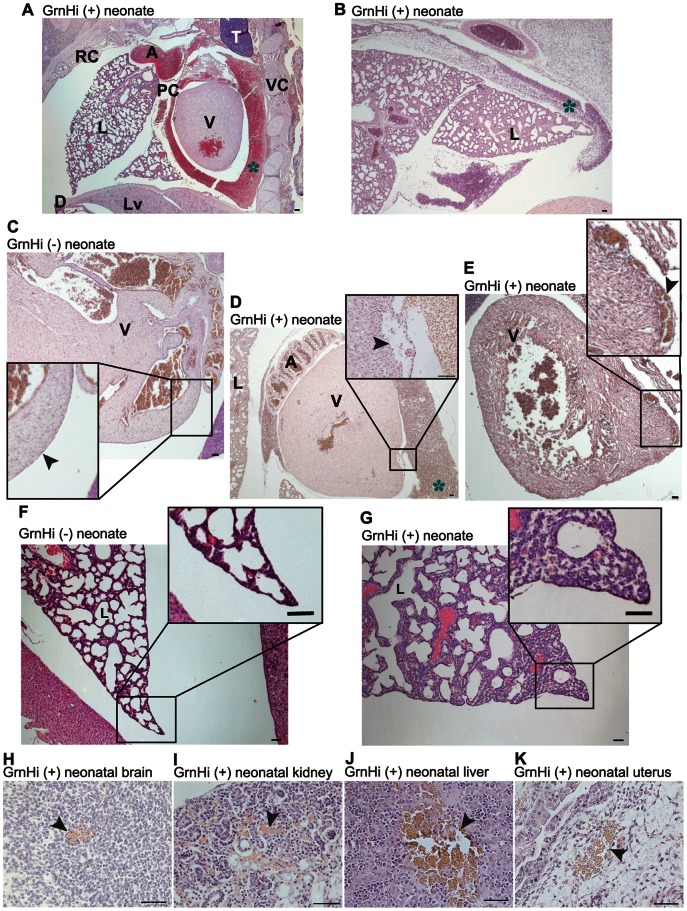
Vascular abnormalities and altered lung structure in Tie2-Grn positive neonatal mice.Extravasated blood (*) in the pericardial cavity (A) and in the pleural cavity adjacent to the lung (B) of Tie2-Grn positive neonates. (C) The heart from a Tie2-Grn negative neonate; note the absence of blood in the pericardial space. The insert shows a higher power view of the normal epicardial wall (arrow). (D) Blood pooling in the pericardial cavity of aTie2-Grn positive neonate; note the ruptured vessel shown at higher power magnification in the insert (arrow). The neonates shown in (A–D) were collected alive, the transgenic neonates in A, B and D died soon after collection. (E) The heart from a post-mortem Tie2-Grn positive neonate; note the absence of bleeding into pericardial space but the presence of enlarged epicardial vessels (arrow) in the ventricle wall, shown at higher power magnification in the insert. Appearance of the lungs in a (F) Tie2-Grn negative neonate and (G) a matched Tie2-Grn positive neonate. Note that the alveolation is incomplete in the Tie2-Grn positive neonate with small alveoli and thickened mesenchymal alveolar wall (G). Localized hemorrhages (arrows) were observed in multiple organs of Tie2-Grn positive mice at birth including (H) brain, (I) renal cortex, (J) liver, and (K) uterus. All sections stained with H&E. Scale bars denote 20 µm. Animals were obtained from the GrnHi line. Abbreviations used: A, atrium; D, diaphragm; L, lung; Lv, liver; PC, pericardial cavity; RC, rib cage; T, thymus; V, ventricle; VC, vertebral column.